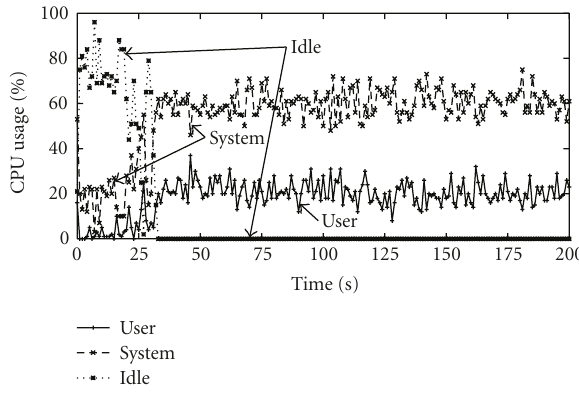
Figure 16: Transmission data rate per channel at node S.